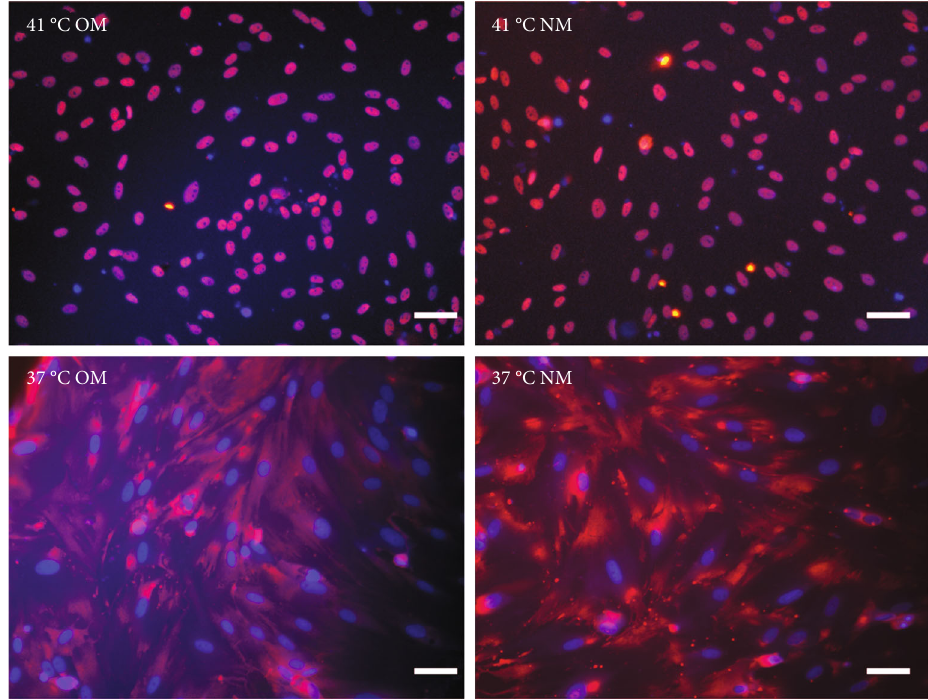
Figure 6: Heat shock activates YAP and induces YAP nuclear localization. EMSCs were subjected to heat shock at 41 ° C or 37 ° C for 1 min, fi xed, immuno fl uorescence stained with anti-YAP antibodies, and examined under a microscope. Representative pictures from three independent samples are shown. Bars = 25 μ m